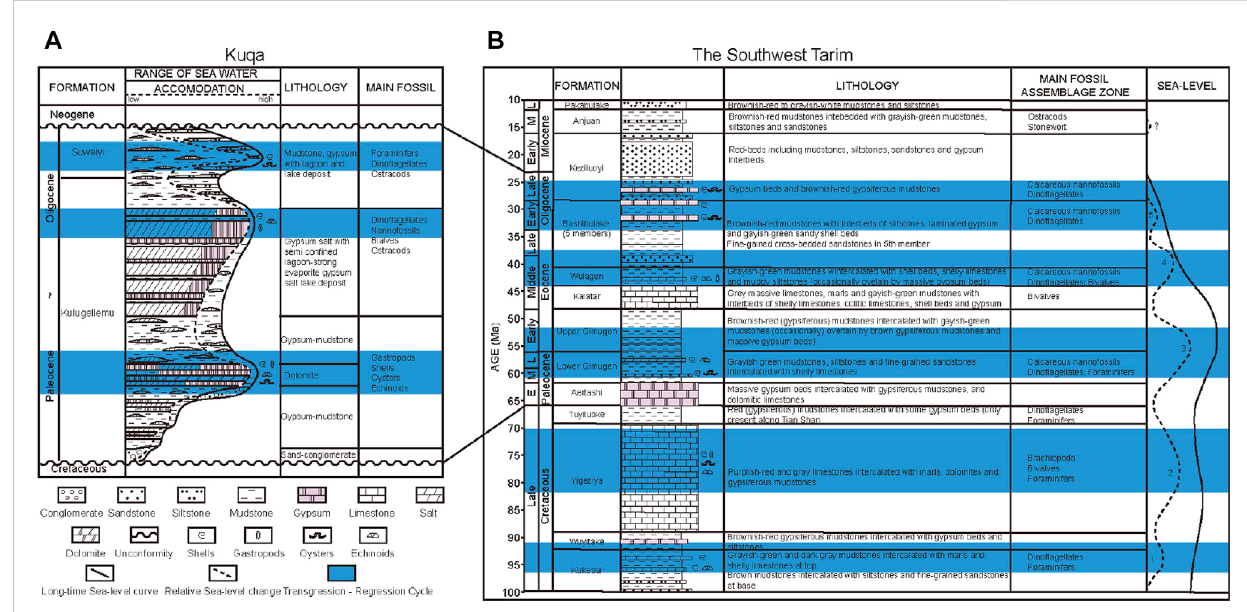
FIGURE 5 Simpli fi ed regional lithostratigraphic framework in Kuqa (A) and lithostratigraphic framework and main fossil assemblage zone of marine incursions in Southwest Tarim (B) (modi fi ed after Bosboom et al., 2011; Bosboom et al., 2014; Ma CM. et al.,